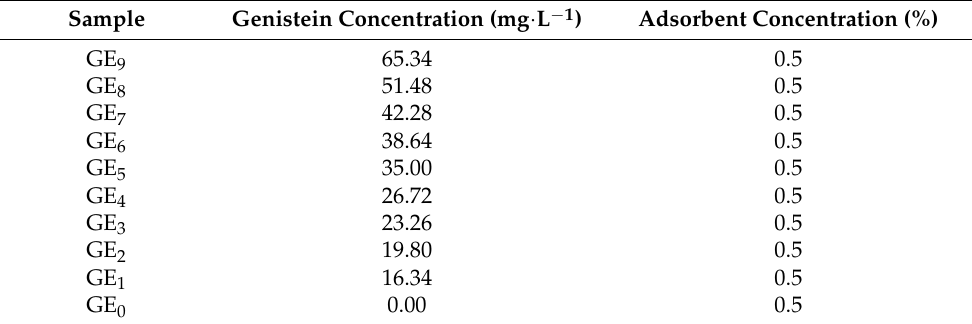
Table 5. Concentrations of genistein for adsorption isotherms